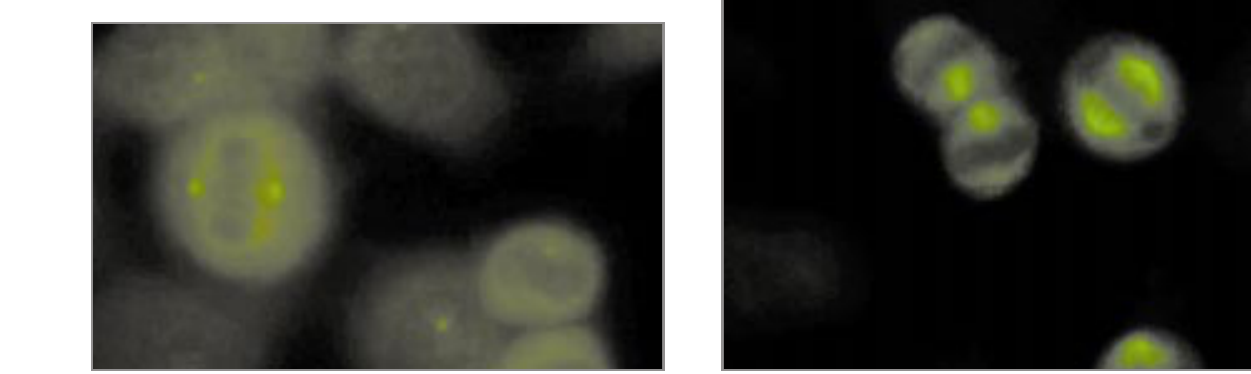
Figura 24 – Fuso mitótico NuMA 2